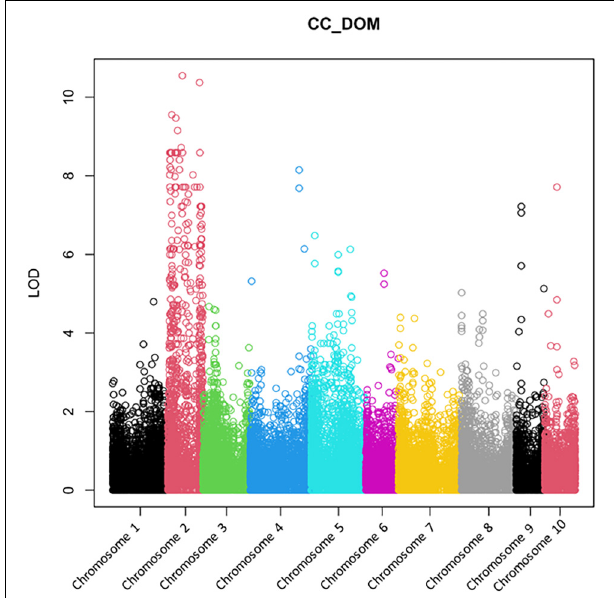
FIGURE 2 | A Manhattan plot of the GBS analysis using data of 32 AV-1-susceptible and 19 AV-1-resistant plants from the pedigree of the backcross programme and cultivars ( Supplementary Table 4 ). The genome comparison shows a clear association of the AV-1 resistance with asparagus Chromosome